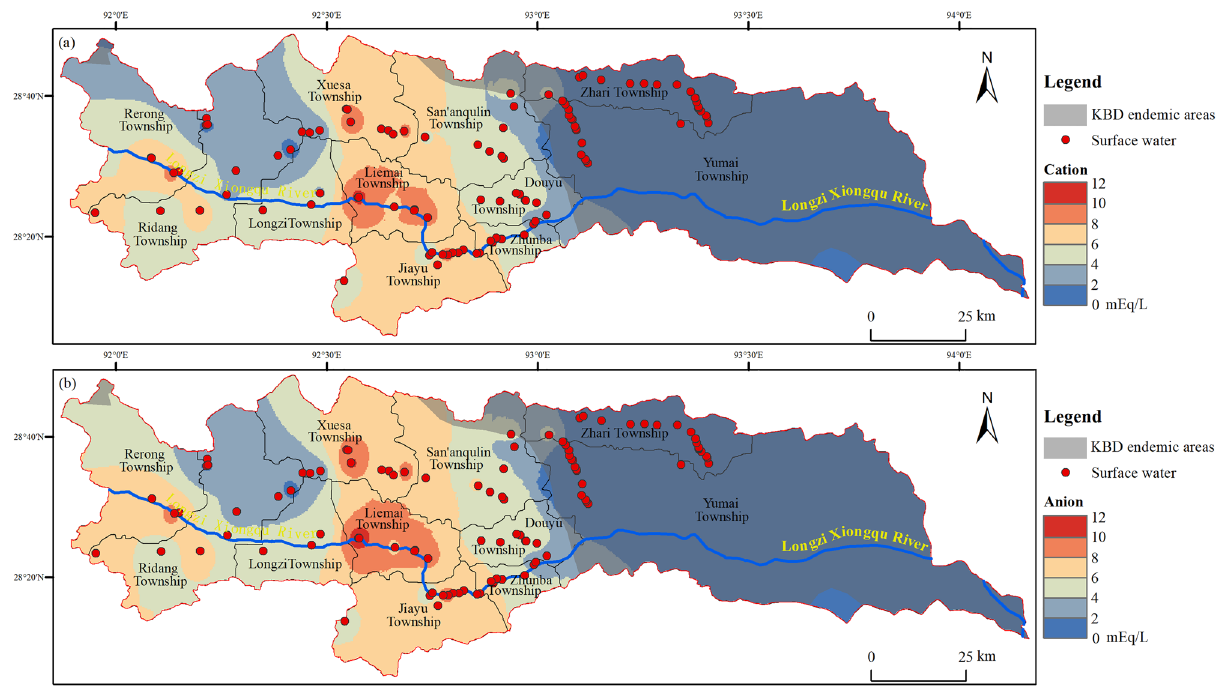
Figure 3. Maps showing distributions of the milliequivalent of ( a ) cations and ( b ) anions in surface waters in the Longzi County (this figure was created with ArcGIS 10.8, URL: https:// www. esri. com/ en- us/ arcgis/ produ cts/